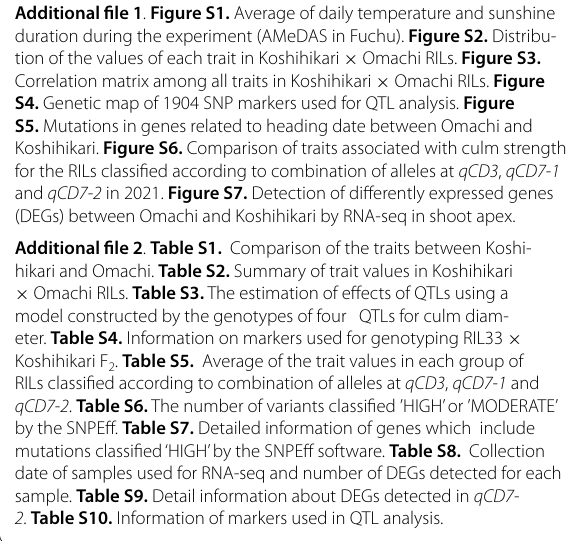
2 . Table S10. Information of markers used in QTL